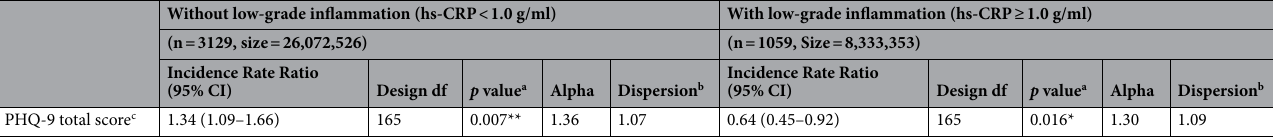
Table 2. The association between uric acid concentrations and depressive symptoms stratified by low- grade inflammation status. Analysis done by negative binomial regression with adjustment for complex sample designs. hs-CRP = high sensitive C-reactive protein, CI = confidence interval, df = degree of freedom, PHQ-9 = Patient Health Questionnaire-9. a p values are significant at α = 0.05 (*), 0.01 (**), and 0.001(***). b Dispersion based on Pearson. c Adjusted for age, sex, region, income, education, unemployment, marital status, alcohol use, smoking behavior, aerobic exercise, history of cancer, history of arthritis, hypertension, diabetes, hypercholesteremia, obesity, anemia, serum AST, serum creatinine, serum hs-CRP, daily energy intake, and daily protein